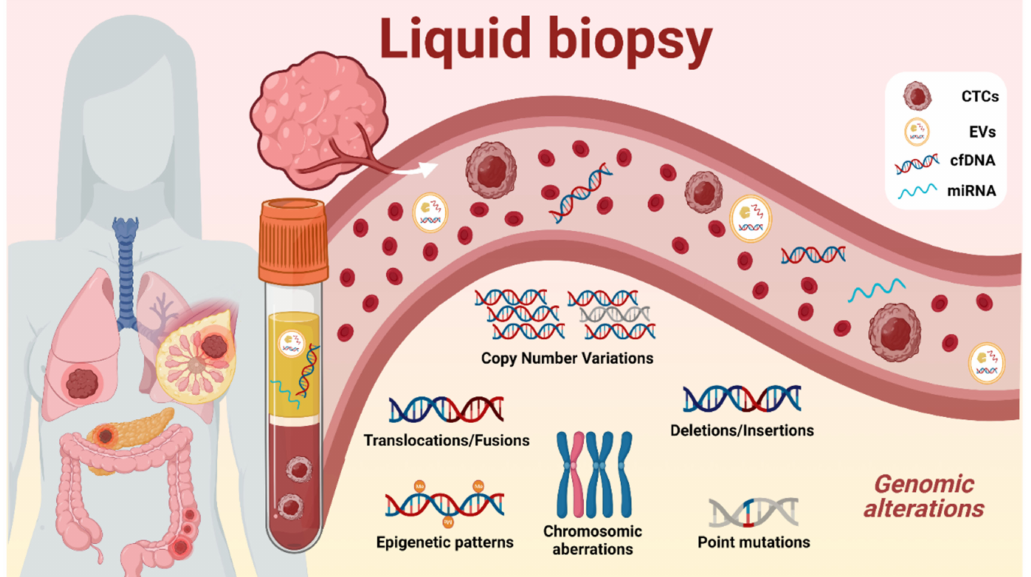
Figure 1. Schematic of the liquid biopsy composition. Liquid biopsy obtained from peripheral blood is composed of different tumoral components such as circulating tumor cells (CTCs), circulating cell-free DNA (cfDNA), extracellular vesicles (EVs), and micro-RNA (miRNA). These elements can be isolated for the identification of various tumor-specific genomic aberrations including point mutations, copy number variations, structural rearrangements, or epigenetic